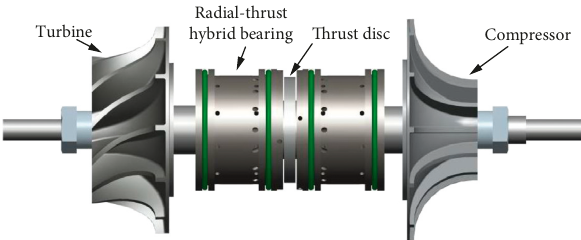
Figure 1: Structure diagram for air cycle machine rotor system.